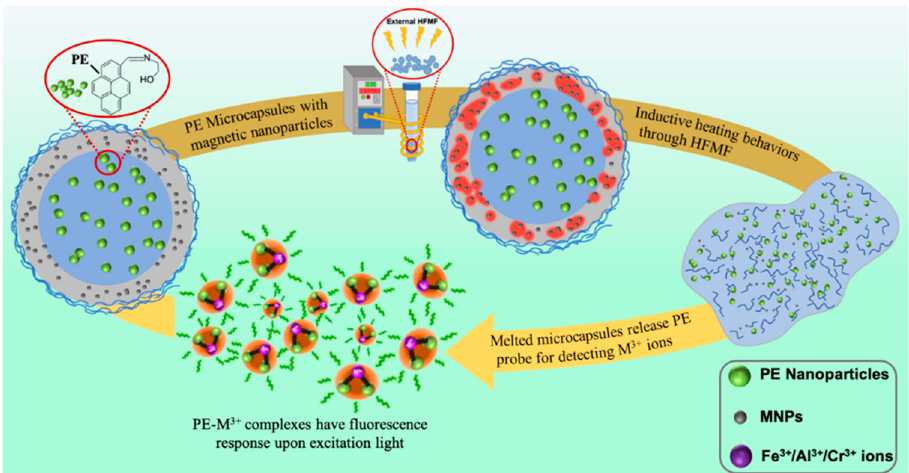
Figure 1. Mechanism of action of magnetic-sensitive microcapsules for sensing trivalent cations.